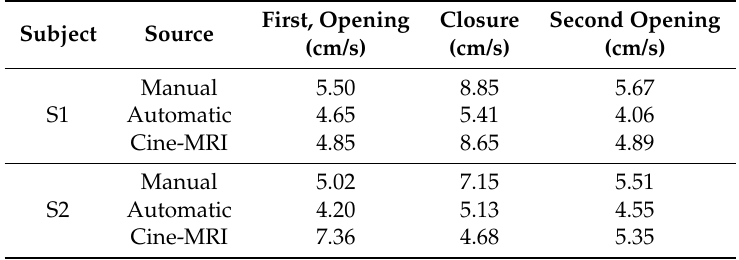
Table 4. Mean values of the velocity of the tongue tip during different phases of the